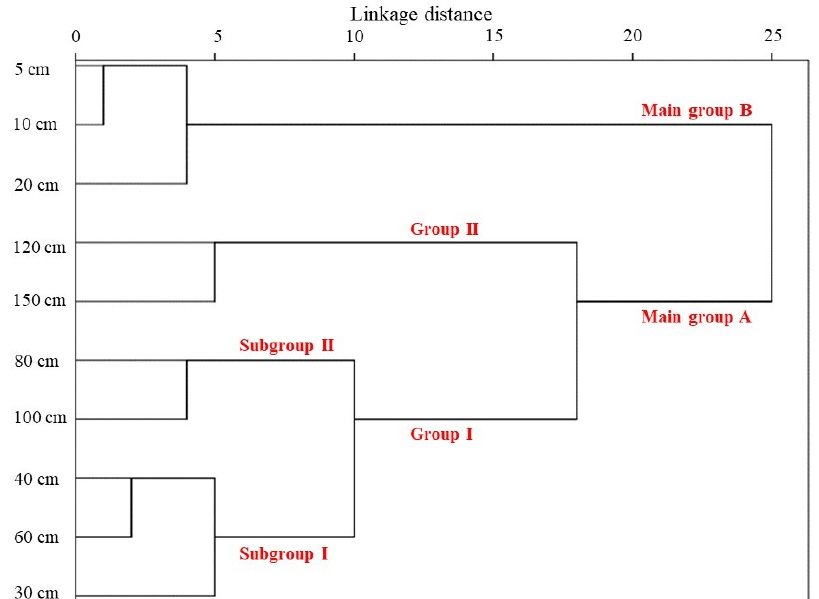
Figure 3. Hierarchical cluster analysis diagram of the soil water content.